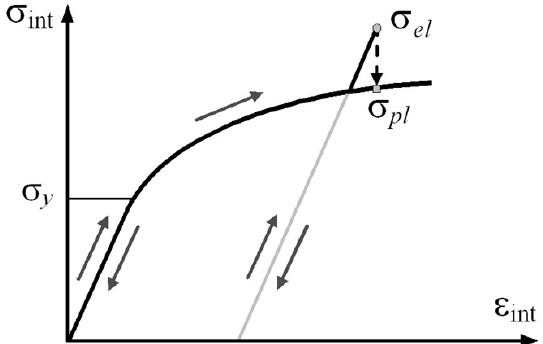
is stress intensity after elastic problem el is an “initial” value of yield y